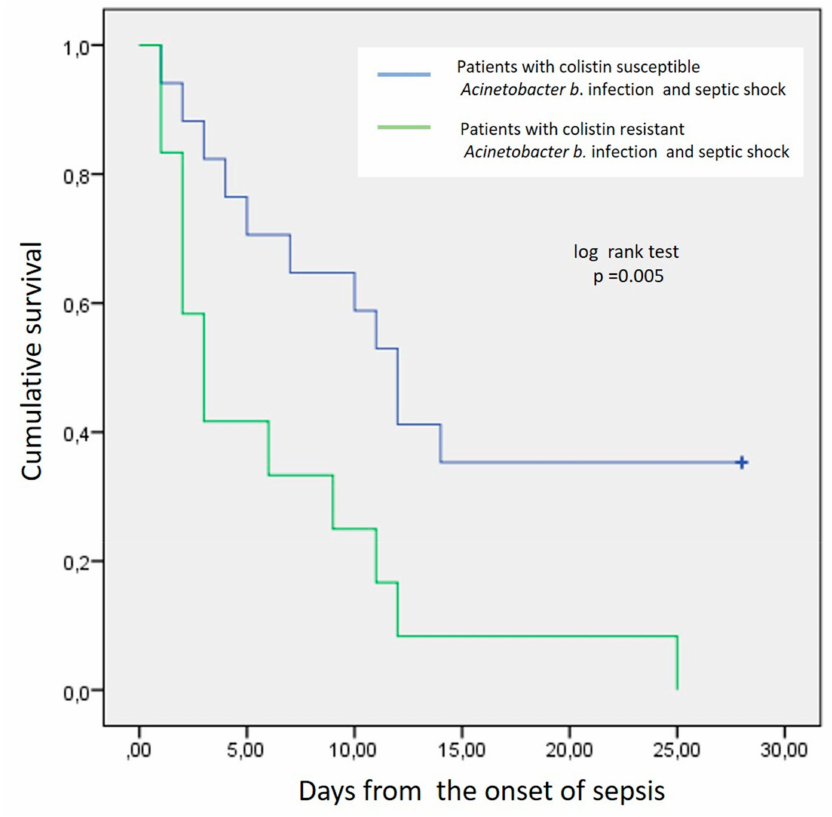
Figure 2. Kaplan-Meier survival curve for total mortality of AB septic shock